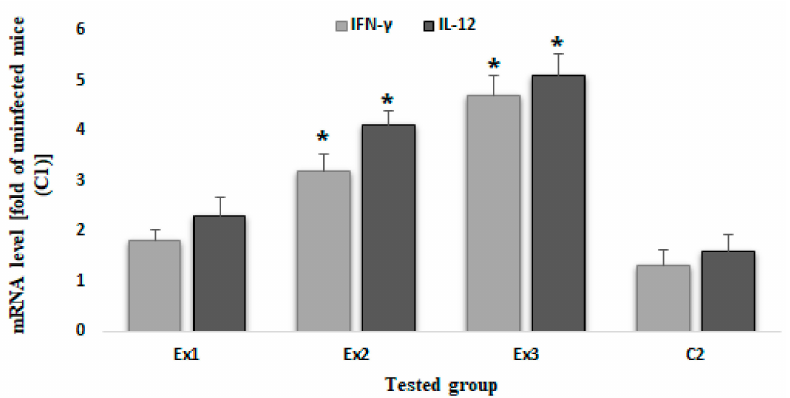
Figure 3. The expression level of genes producing IFN- γ and IL12 cytokines in mice treated with MCEO. The results demonstrated that although the mRNA levels of IFN- γ and IL-12 were elevated in all mice of experimental groups, a significant increase ( p < 0.001) was observed in tested groups of Ex2 (200 mg/kg) and Ex3 (300 mg/kg), when compared with control groups. * p <